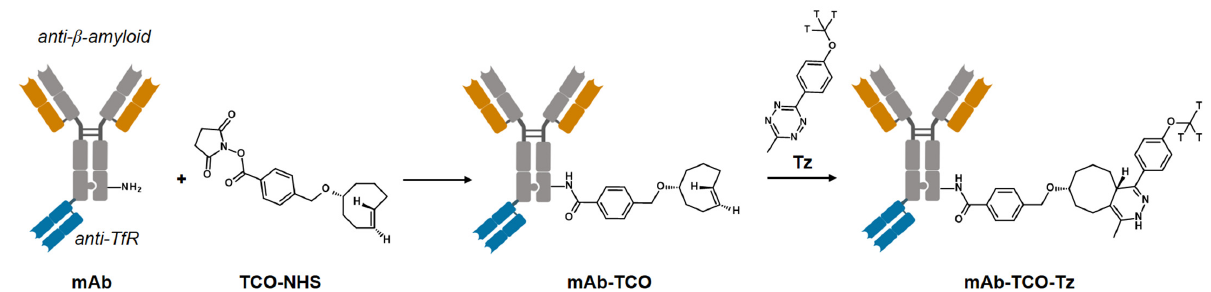
Figure 1. Nomenclature of compounds used in this study. Conjugation of NHS–TCO to mAb and